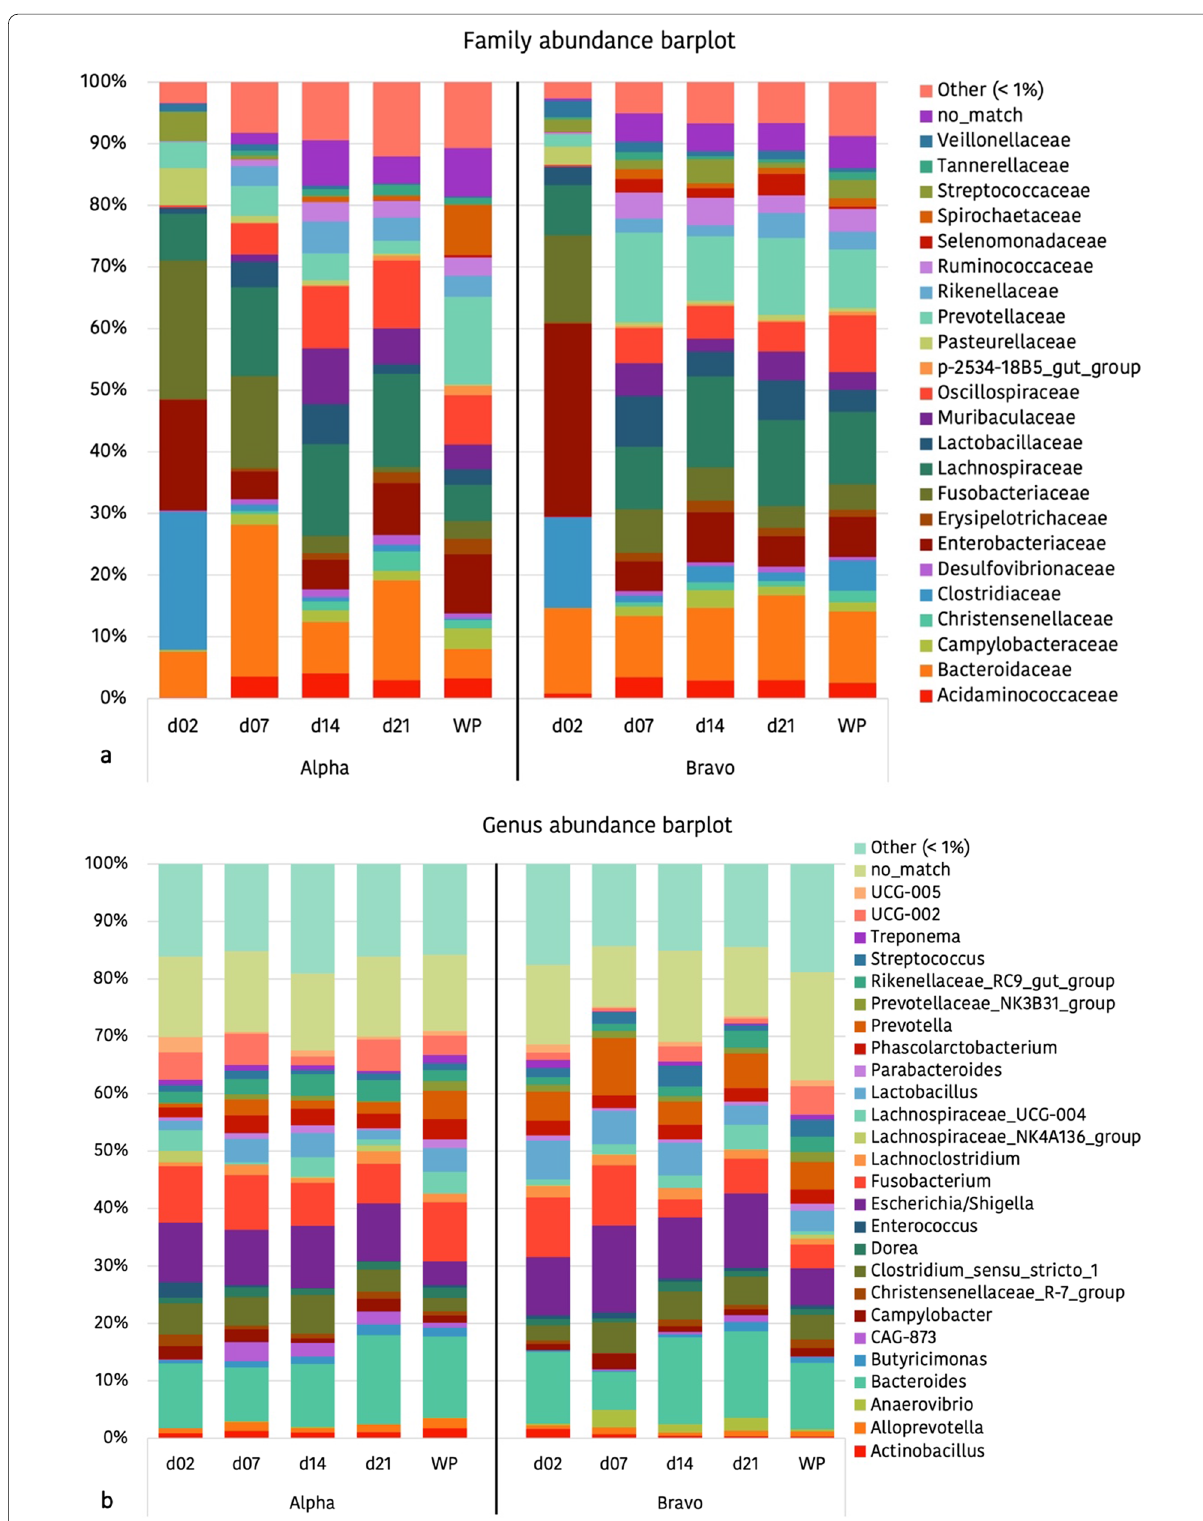
Fig. 3 Bar diagram of the relative abundances (%) of the main (> 1%) families ( a ) and genera ( b ), organized by farm (Alpha or Bravo) and by age. WP Weaned =